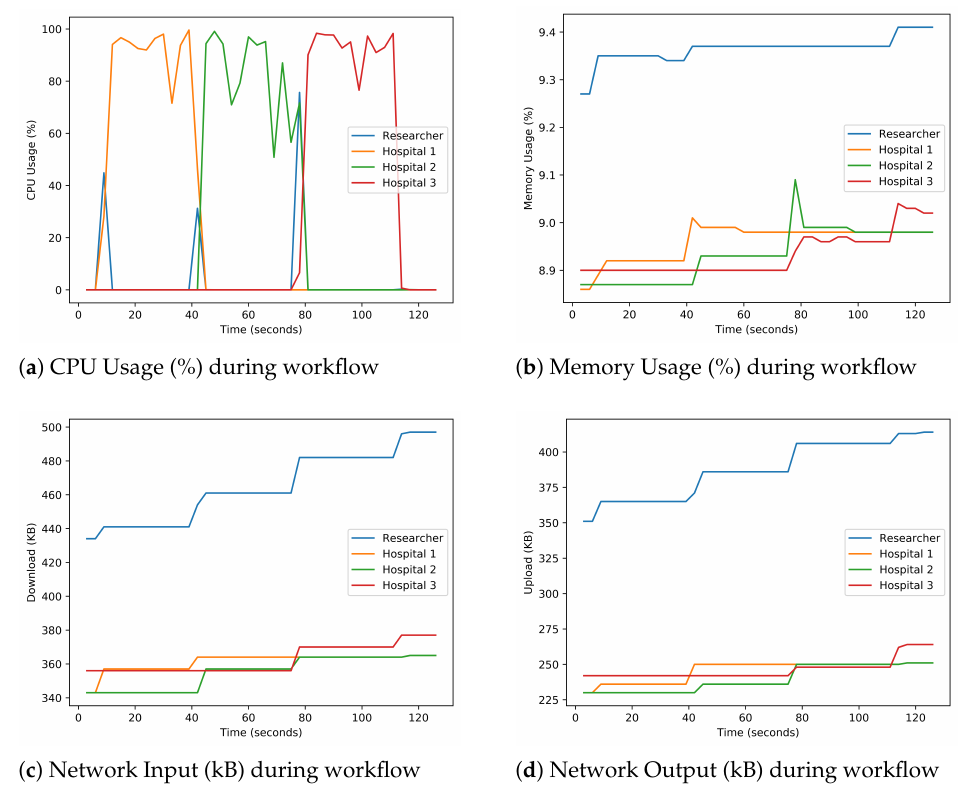
Figure 4. CPU, Memory usage and Network use of Docker container agents during workflow using the original federated learning architecture [27].